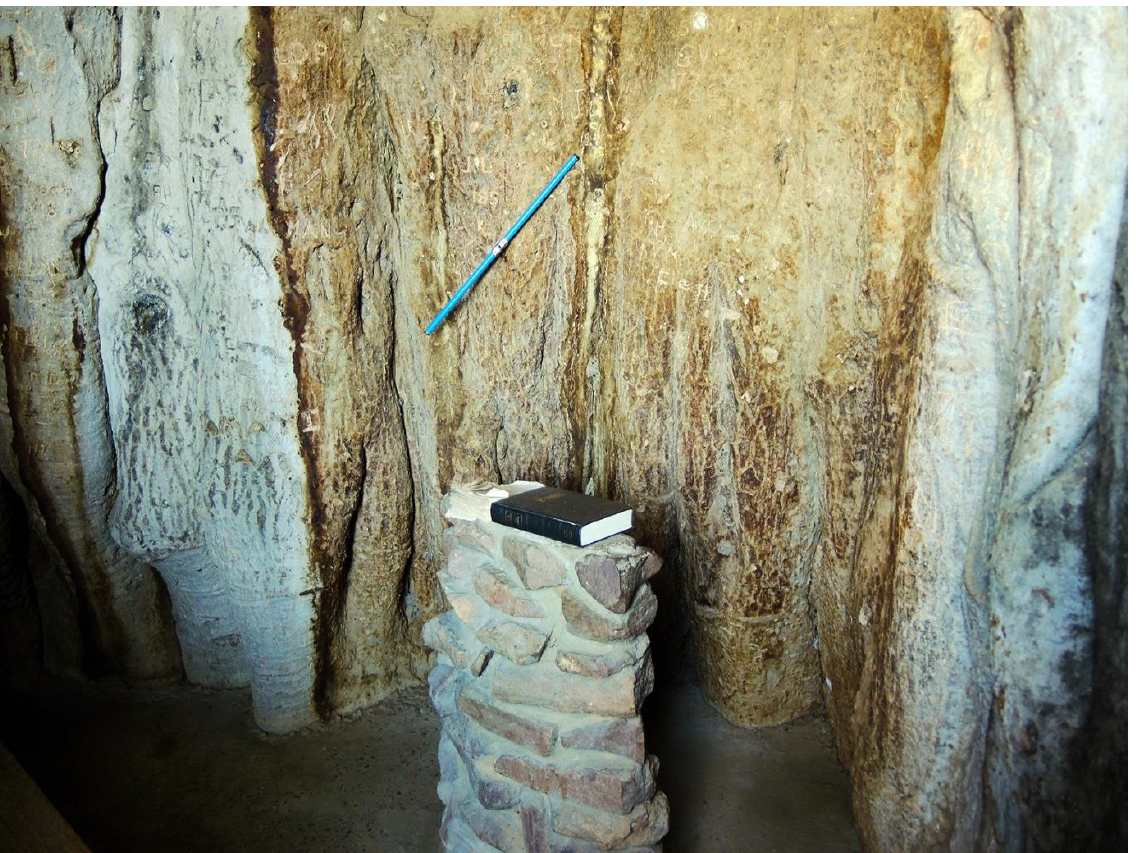
Figure 13. The oldest dated sample OMB-1 from the Ombalantu baobab originates from the walls of the false cavity, above the altar.